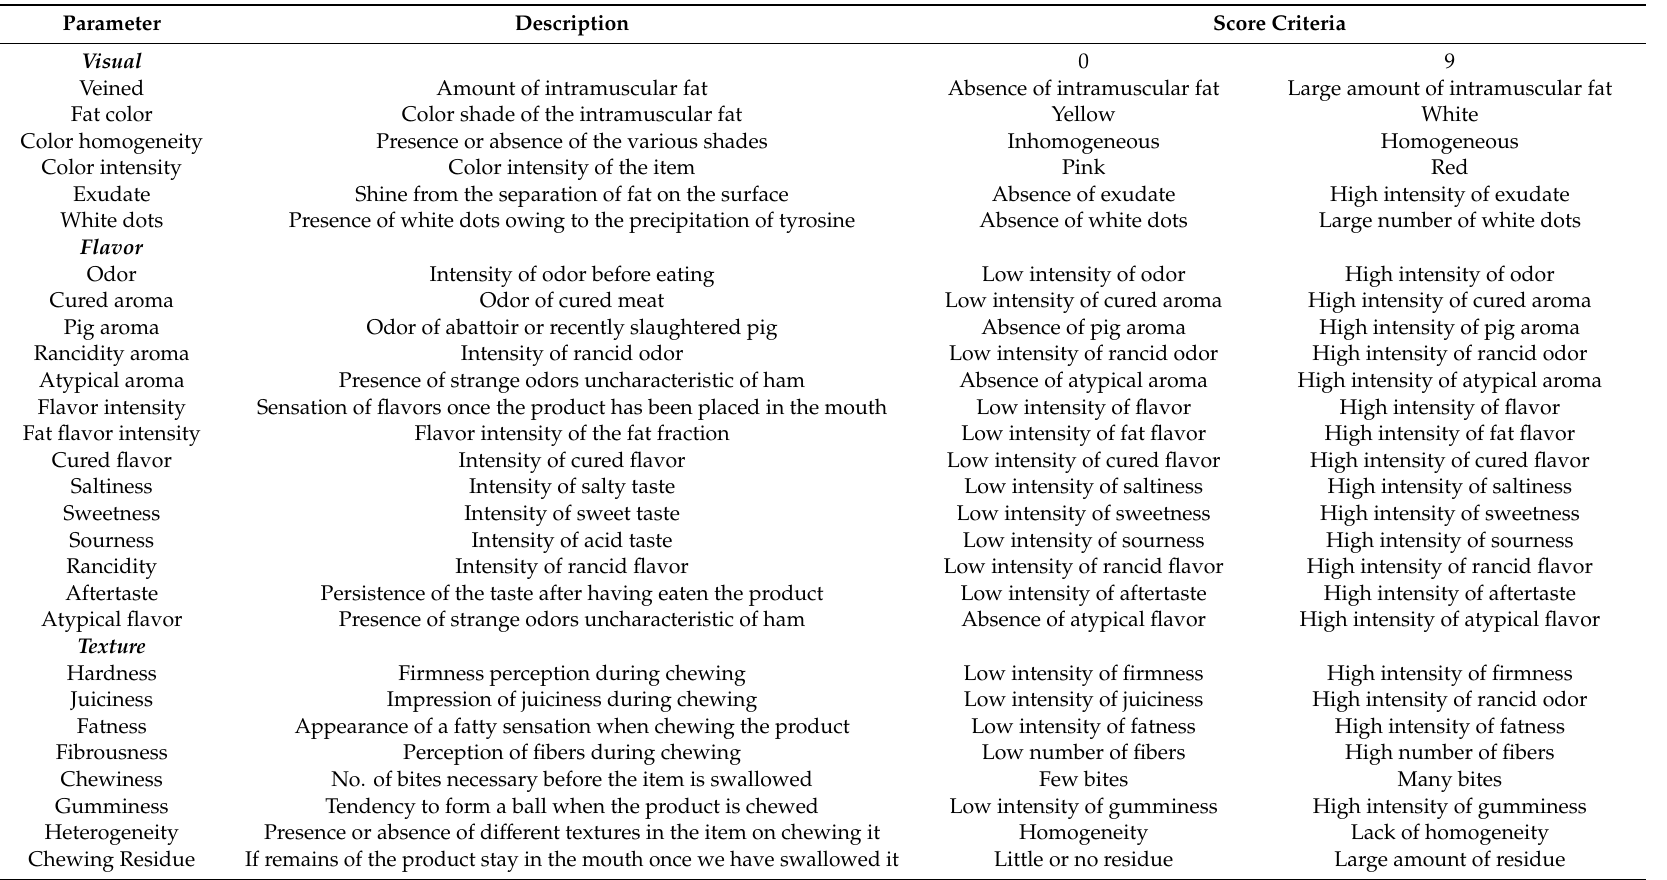
Table 1. Sensory parameters selected by the assessors and the definition of sensory